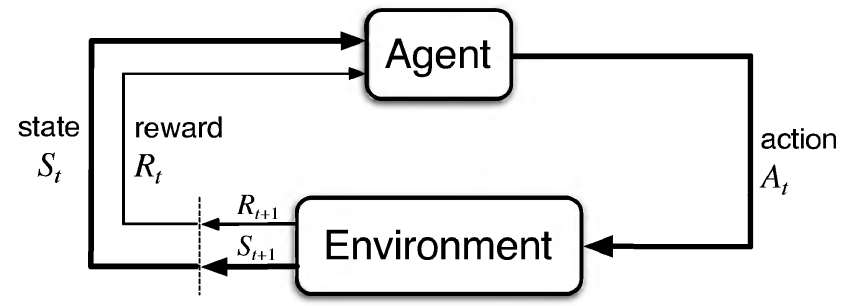
Figure 1. The agent–environment interaction is made at discrete time-steps t = 0,1,2, . . . . At each time-step t , the agent uses the state S t ∈ S given by the environment to select an action A t ∈ A . The environment answers with a real number R t + 1 ∈ R ⊂ R , called a reward, as well as a next state S t + 1 . Going on, we obtain a trajectory S 0 , A 0 , R 1 , S 1 , A 1 , R 2 , . . . Ref. [8] (Figure